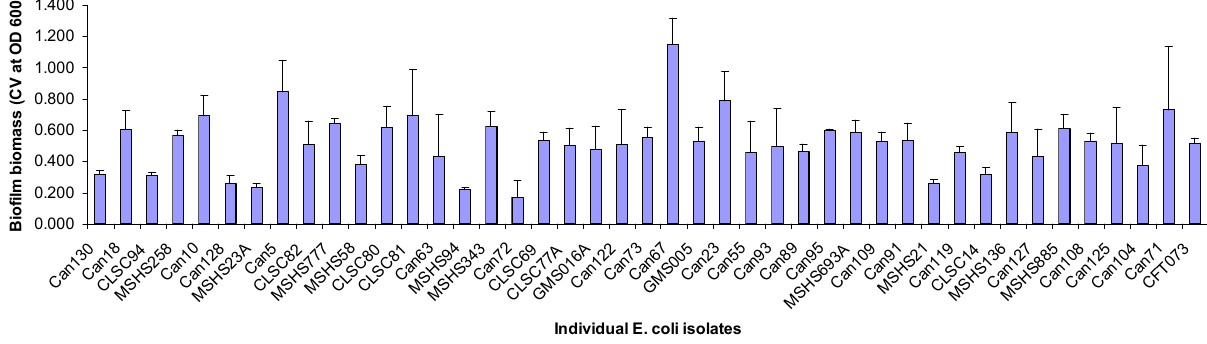
Figure 1. Urinary tract infection (UTI) E. coli isolates positive for biofilm formation on 96-well microtiter plates. Isolates were considered as biofilm formers if the OD crystal violet-stained biofilm was equal to or greater than 3-fold the OD free medium. Data points represent an average of three independent experiments, each with 6 replicate wells for each isolate tested. Isolate CTF073 is a positive control for biofilm formation. Error bars indicate standard error of